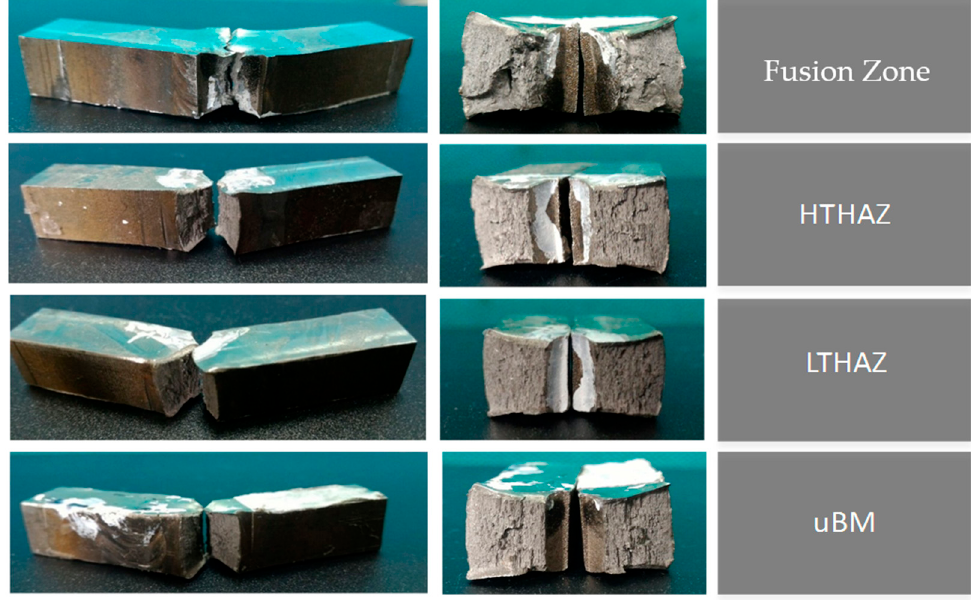
Figure 11. Macro image of impact fracture.